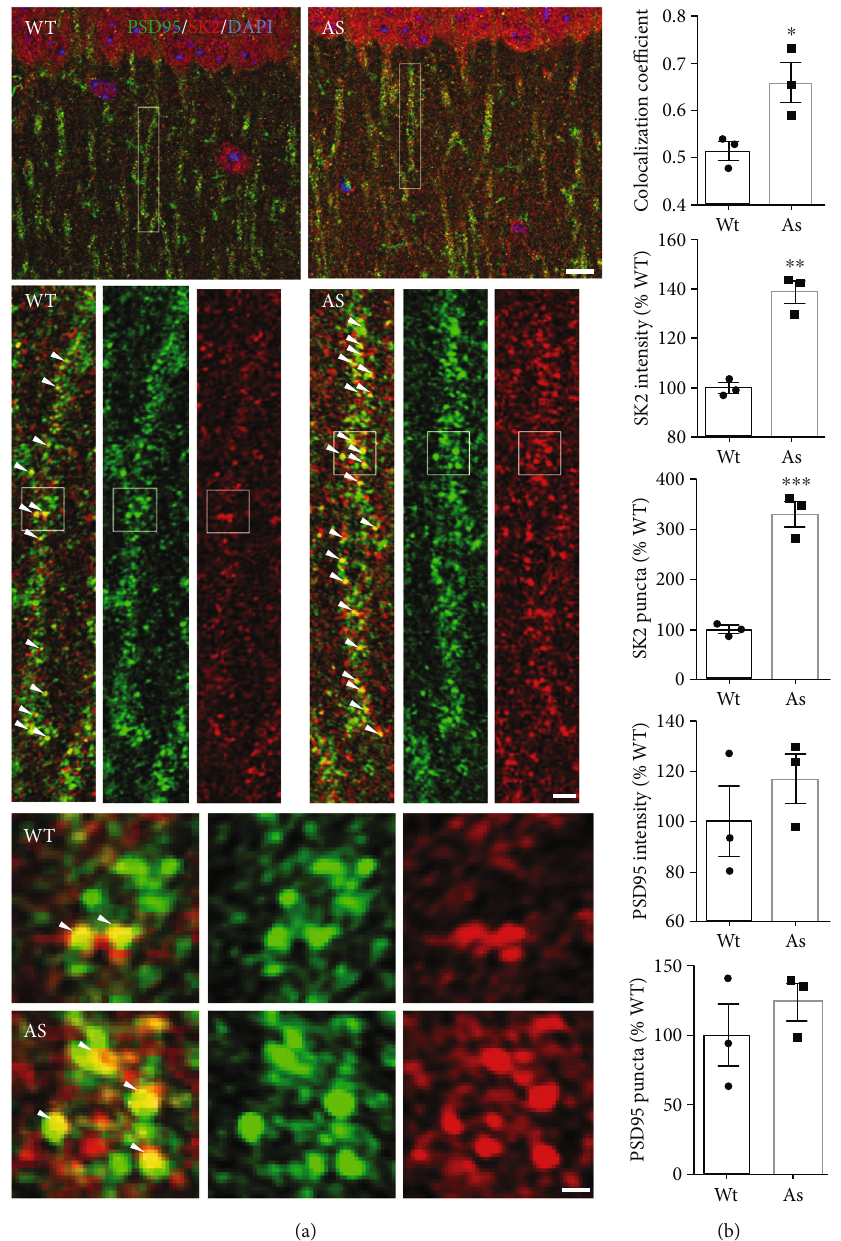
Figure 2: Localization of synaptic SK2 in hippocampal CA1 region of female AS and WT mice. (a) Representative images of CA1 pyramidal neurons stained with anti-SK2 (red) and -PSD95 (green) antibodies. Middle panels are enlarged images of boxed areas in top panels and bottom panels are enlarged images of boxed areas in middle panels. Arrowheads indicate clearly colocalized puncta. Top panels, scalebar = 10 μ m. Middle panels, scale bar = 2 μ m. Bottom panels, scale bar = 0 : 5 μ m. (b) Quantitative analysis of the intensity and number of SK2- and PSD95-immunoreactive puncta and SK2 and PSD95 colocalization in hippocampal CA1 region. N = 3 mice per group (unpaired t-test, ∗ P < 0 : 05 , ∗∗ P < 0 : 01 , ∗∗∗ P < 0 : 001